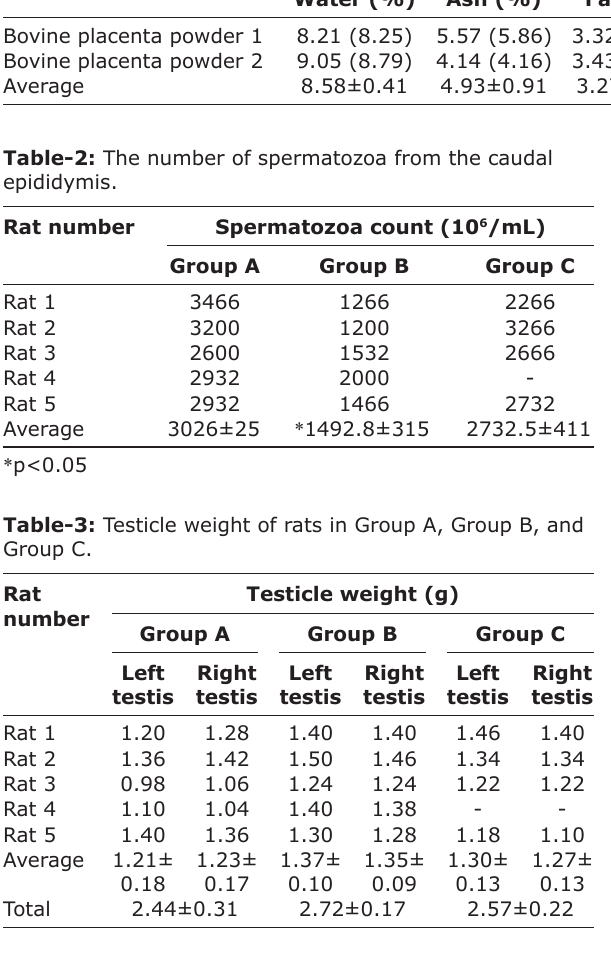
Table-4: Testicle volume of rats in Group A, Group B, and Group C. Rat number